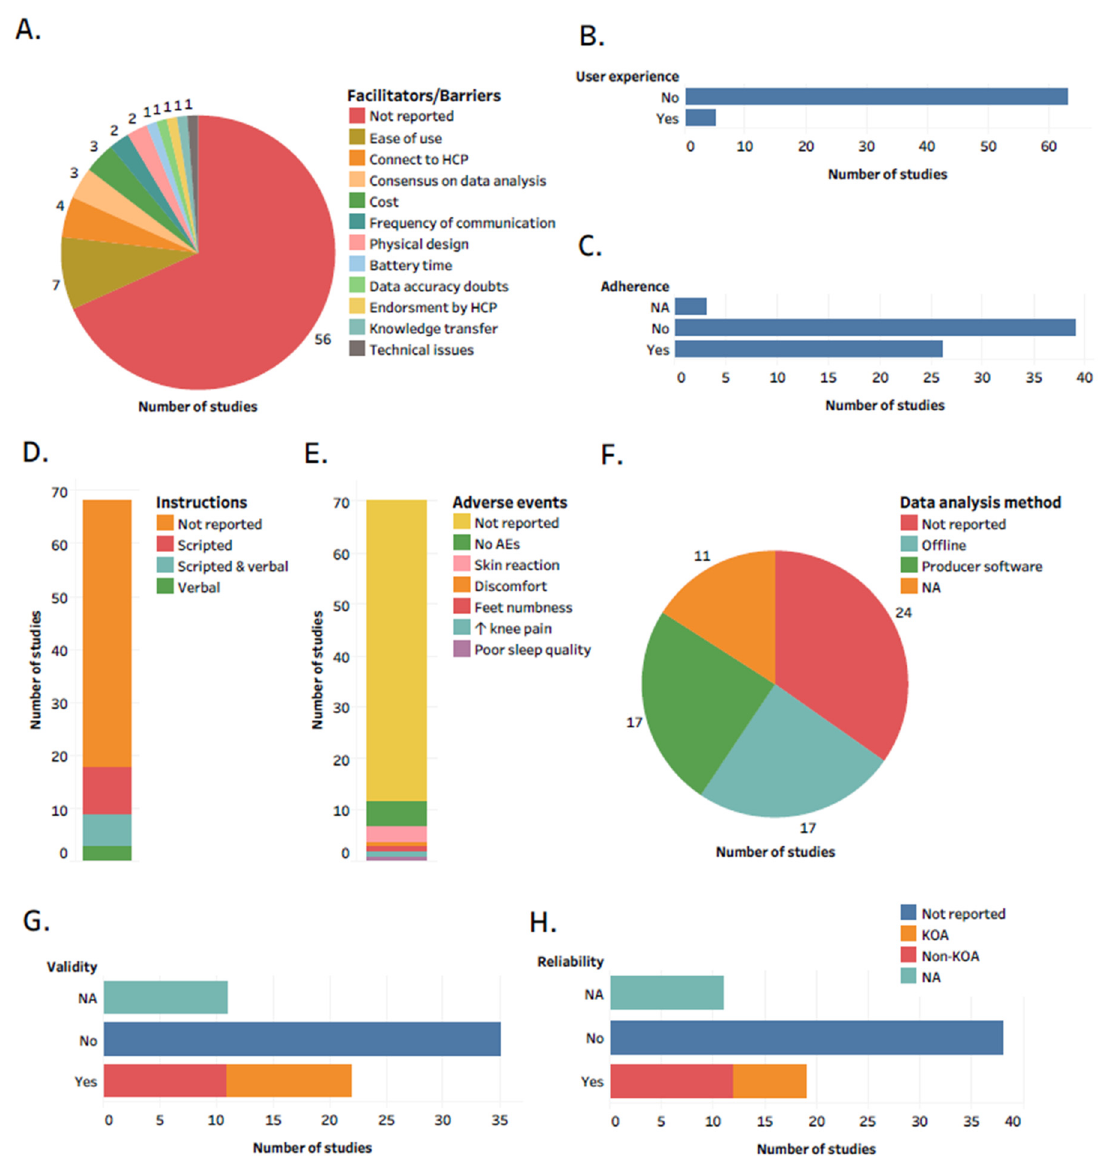
Figure 5. Details regarding facilitators and barriers to the feasibility of using wearable technology in a real-world setting in people with knee OA. The number of studies reported: ( A ) facilitators and barriers; ( B ) user experience; ( C ) adherence; ( D ) instructions provided to participants; ( E ) adverse events; ( F ) how data generated from wearable technology was analyzed; ( G ) validity; ( H ) reliability. Abbreviations: HCP, health care professional; NA, not applicable. KOA, knee osteoarthritis; AEs, adverse events; No, not reported; Yes, reported. Interactive version of the figure with all the study references is located here: https://public.tableau.com/app/profile/tomasz.cudejko/viz/Figure5_16328264416900/Figure5 (accessed on 19 October 2021).